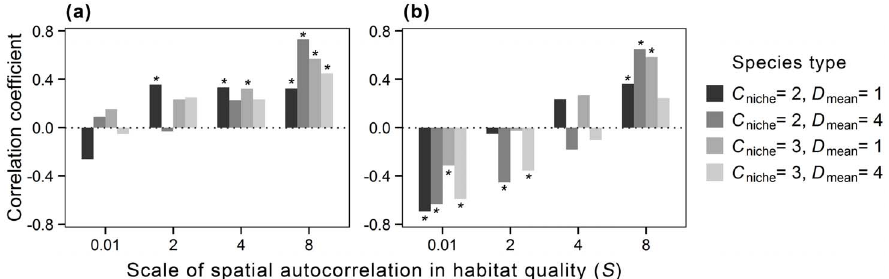
Figure 7. Coefficients of Spearman correlations of the mean resource share of individuals with (a) the proportion of individuals in high-quality cells and (b) the proportion of individuals experiencing competition for four hypothetical species under different landscape scenarios. Bars marked with an asterisk (*) indicate the coefficients are statistically significant at P , 0.05.